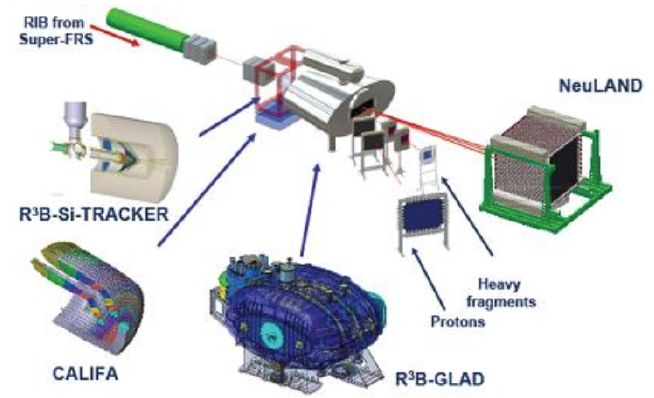
Figure 1. Schematic view of the R 3 B experimental